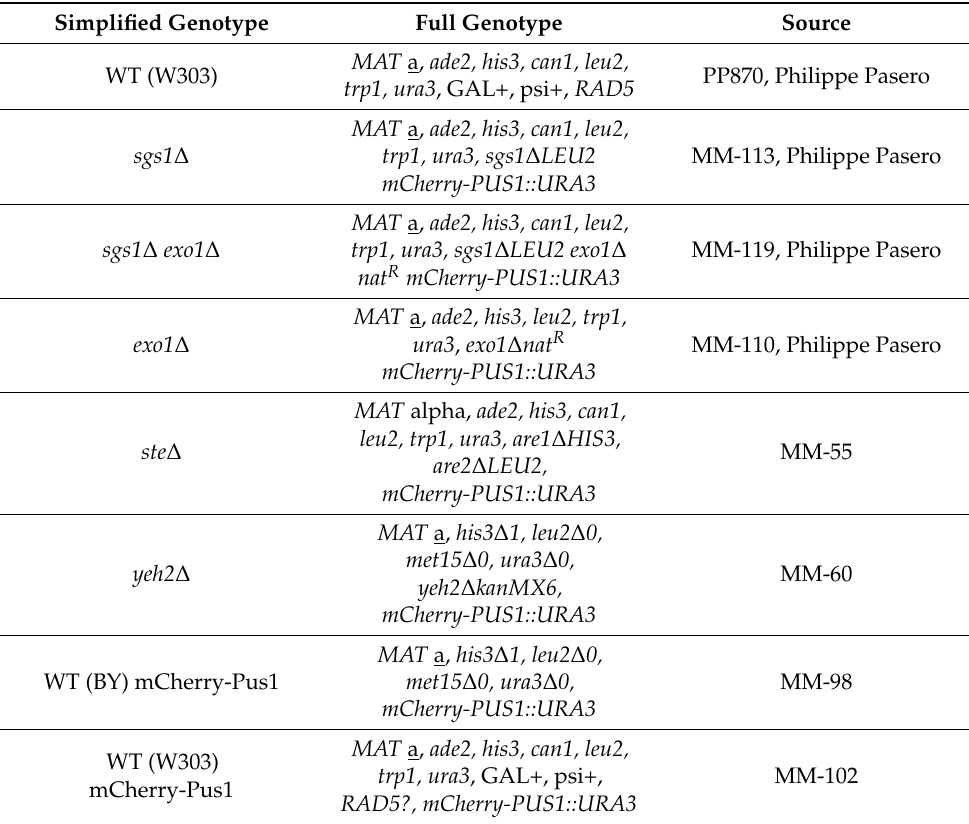
Table 1. Strains used in this